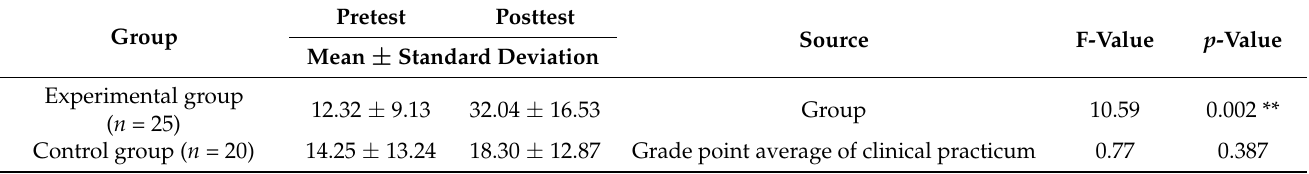
Source F-Value p -Value